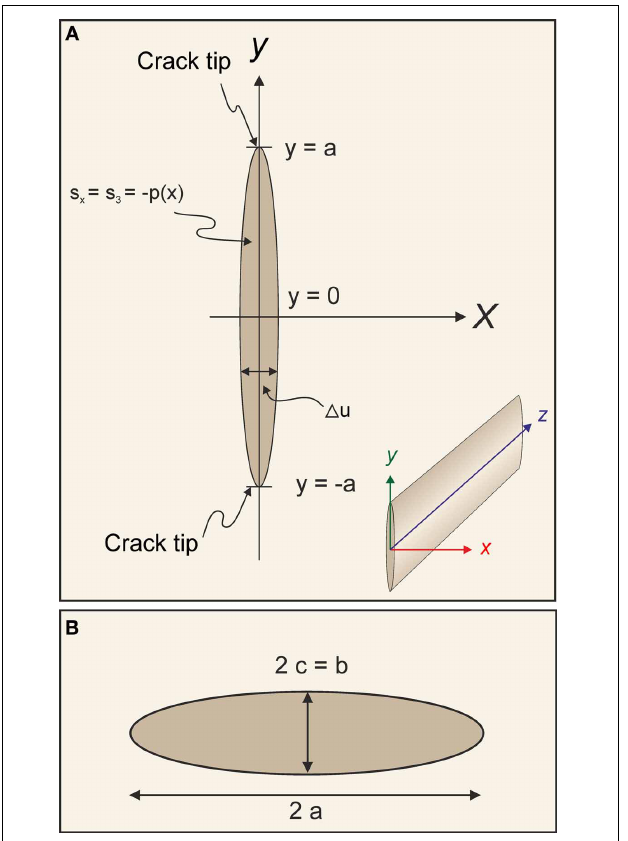
FIGURE 10 | (A) Schematic illustration of a mathematical crack as a fracture representation. The crack has a length 2a along the y-axis and its opening displacement (cid:3) u depends on the fluid overpressure inside the fracture. At the crack tips, the crack-tip tensile stresses become infinite (Equation 7). (B) Schematic sketch of an elliptical hole with a minor axis 2 c = b and a major axis 2a . The crack-tip tensile stress is calculated with Equation